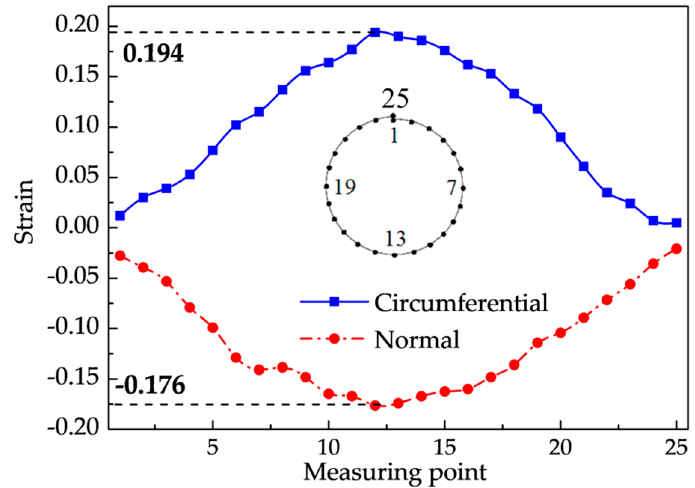
Figure 18. Strain distribution at the middle cross-section.